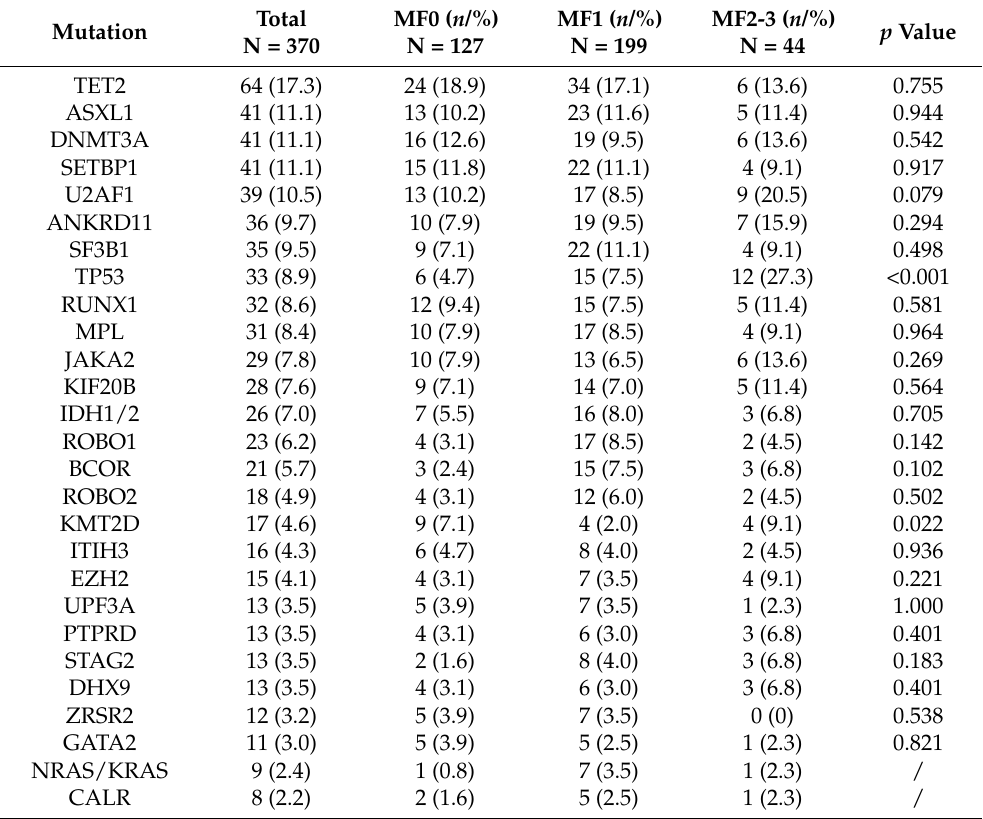
Table 2. Associations of mutations and BM